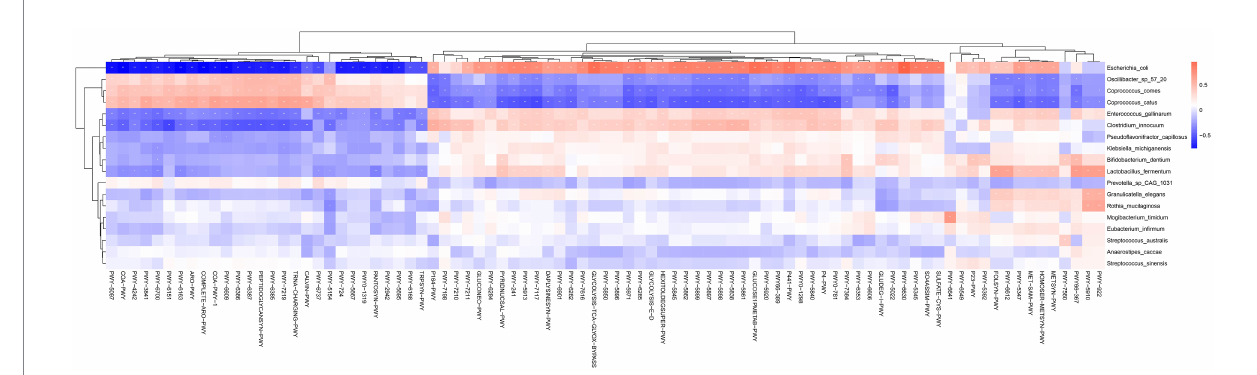
FIGURE 6 Heatmap showing the association between the differential intestinal microbiota of species and 87 differential pathways (STAMP analysis) in all patients. Single asterisks indicate statistical significance based on Spearman correlation with p < 0.05, and double asterisks indicate statistical significance with p < 0.01. Cor. coef., correlation coefficient.